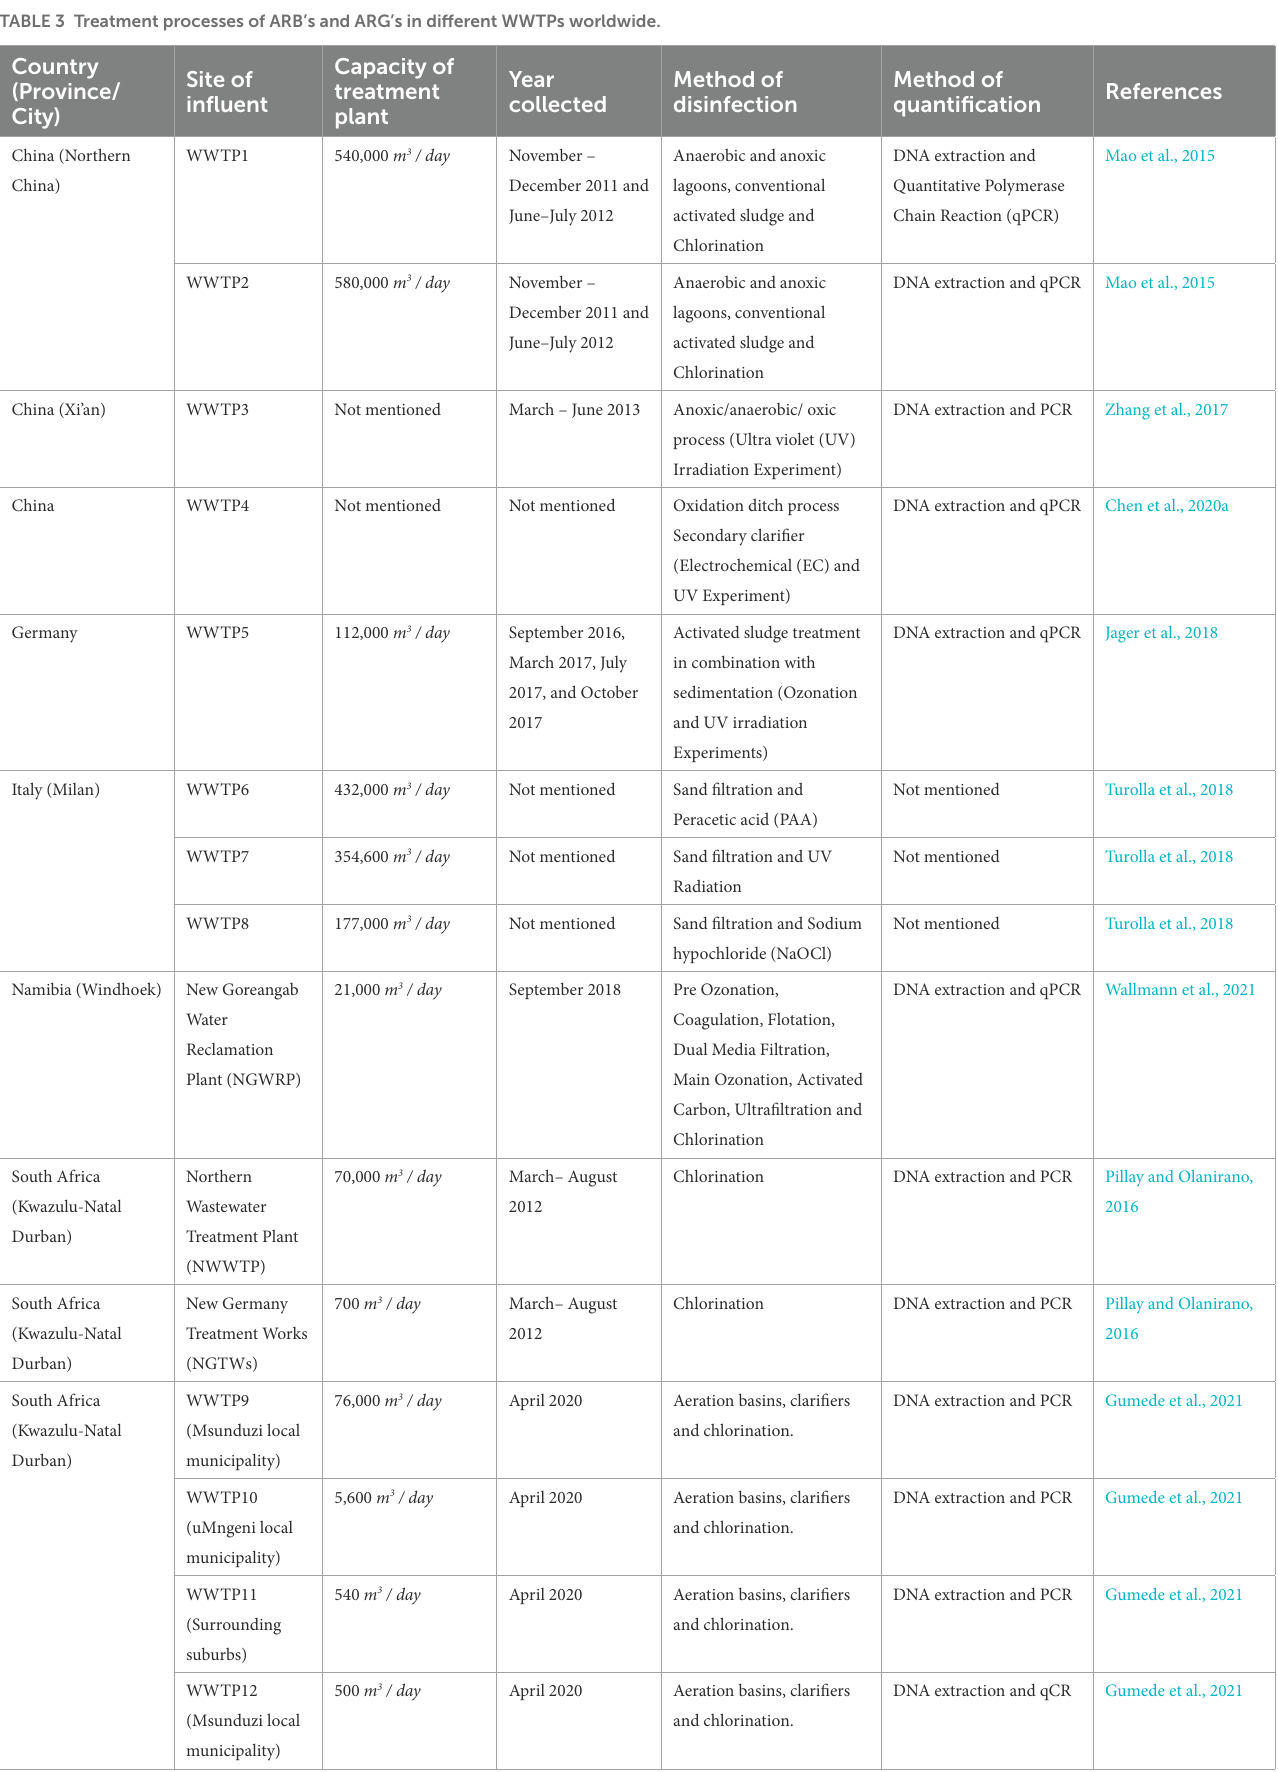
TABLE 3 Treatment processes of ARB’s and ARG’s in different WWTPs worldwide. Country